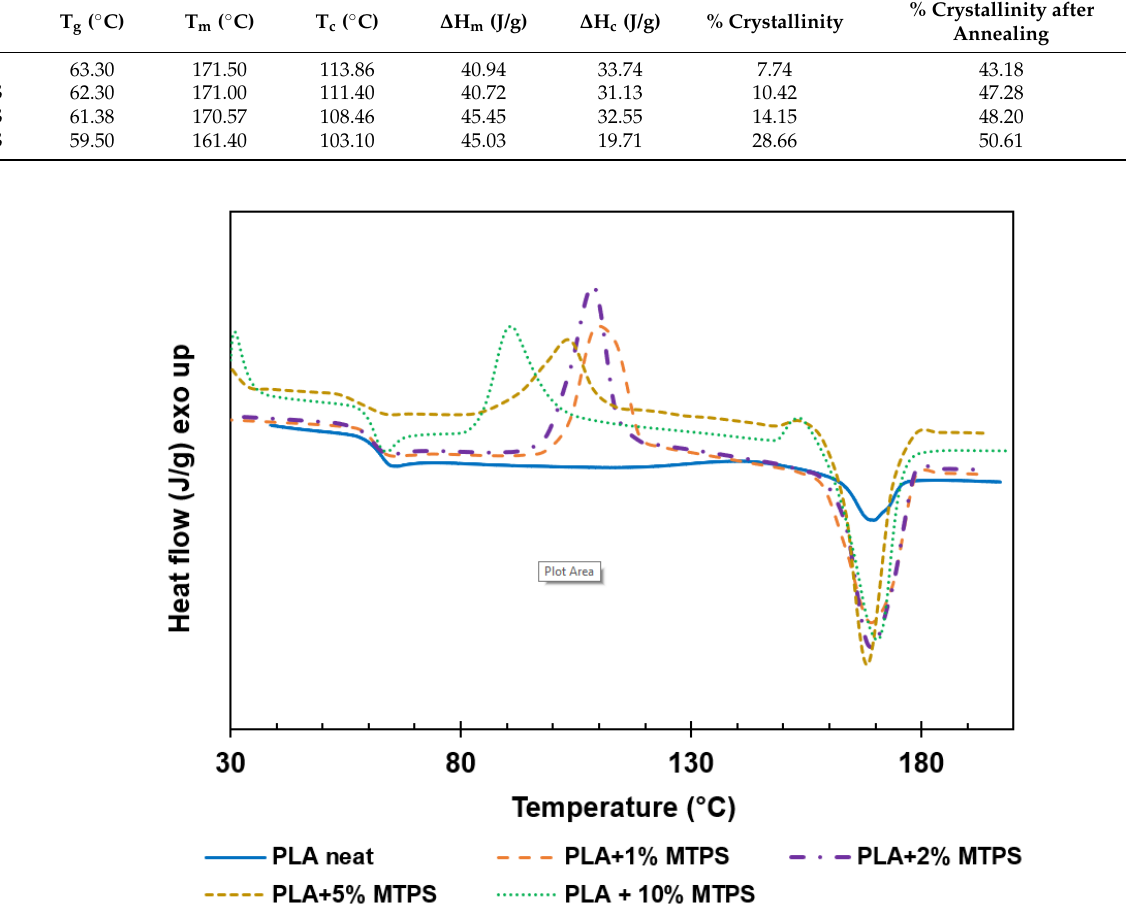
Figure 8. Differential scanning calorimetry (DSC) thermograms of PLA and the blends. From DSC of neat PLA, it seemed that there was just a little endothermic peak on the curve of pure PLA and the crystallinity was about 7.74%. After adding MTPS, an exother ‐ mic peak appeared on the heating curve. In the course of heating, more crystals were formed and hence the crystallinity of PLA increased with increasing concentration of MTPS suggesting its function as a nucleating agent similar to starch [32]. The final crys ‐ tallinity of the samples was also calculated after annealing of the samples as explained in the isothermal crystallization analysis. Figure 9 shows the melting curves for annealed